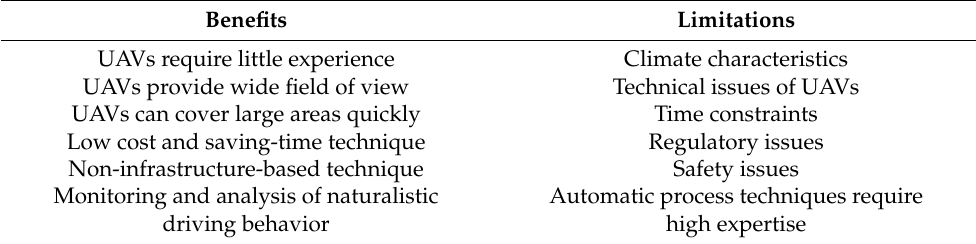
Table 1. The main benefits and limitations of using UAVs for traffic